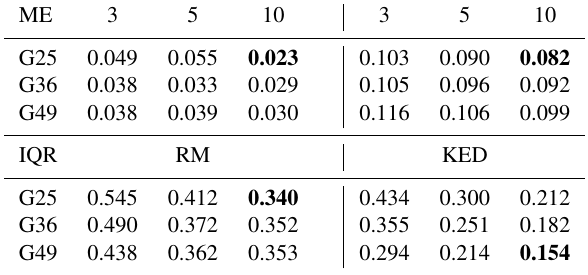
Table 2. The mean error (ME) and the interquartile range (IQR) of the errors w.r.t. the estimated field means for the 1000 true rainfall fields obtained by RM (the three columns on the left) and by KED (the three columns on the right). The column name refers to the SNR of the radar estimates, and the row name denotes the layout of the rain